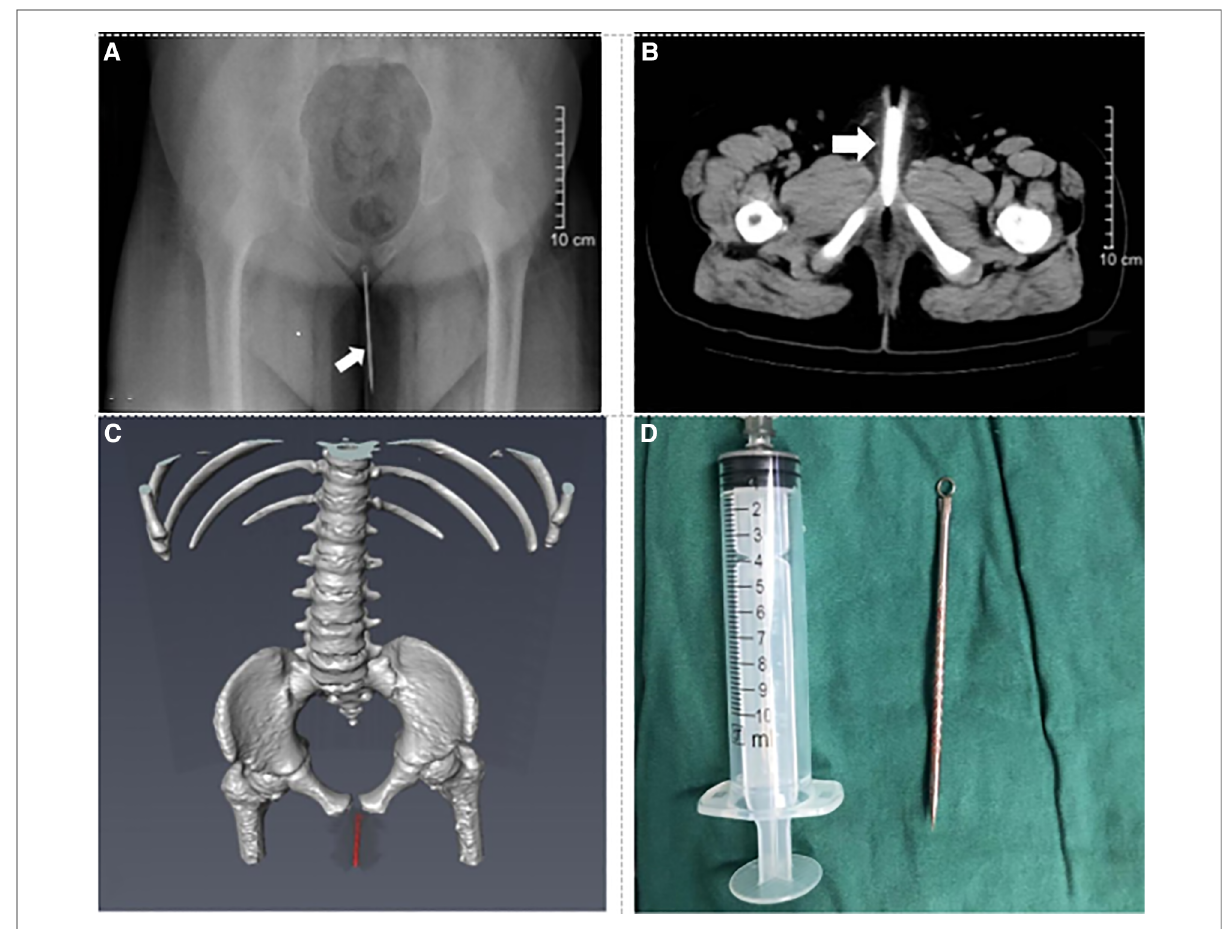
FIGURE 2 Preoperative imaging data and foreign body. ( A ) Plain fi lm x-ray shows the urethral foreign body (see arrow). ( B ) CT of the pelvis shows the straight foreign body in the urethra (see arrow). ( C ) Three-dimensional reconstruction CT shows the straight foreign body in the urethra (red mark). ( D ) Foreign body is an acne needle about 10 cm